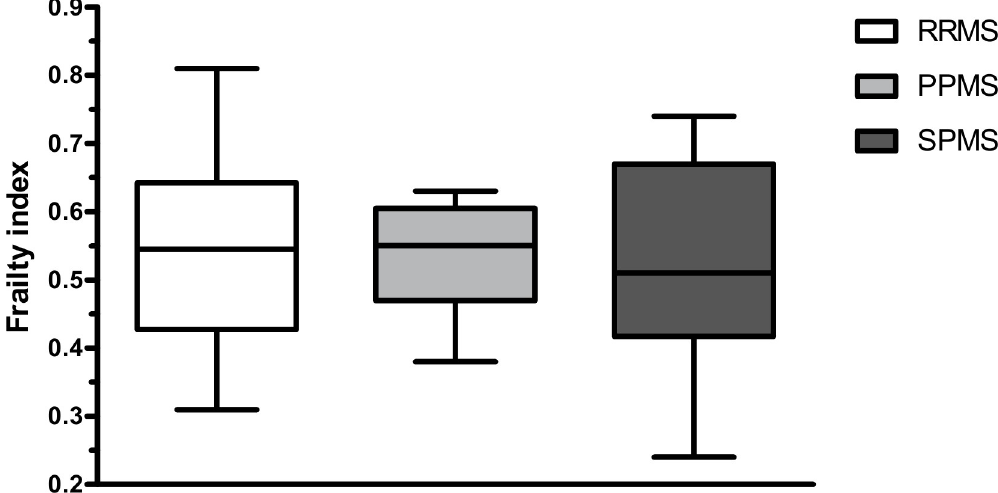
Fig 2. Box plots of the frailty index across different MS clinical subtypes. RRMS = relapsing-remitting multiple sclerosis, PPMS = primary progressive multiple sclerosis, SPMS = secondary progressive multiple